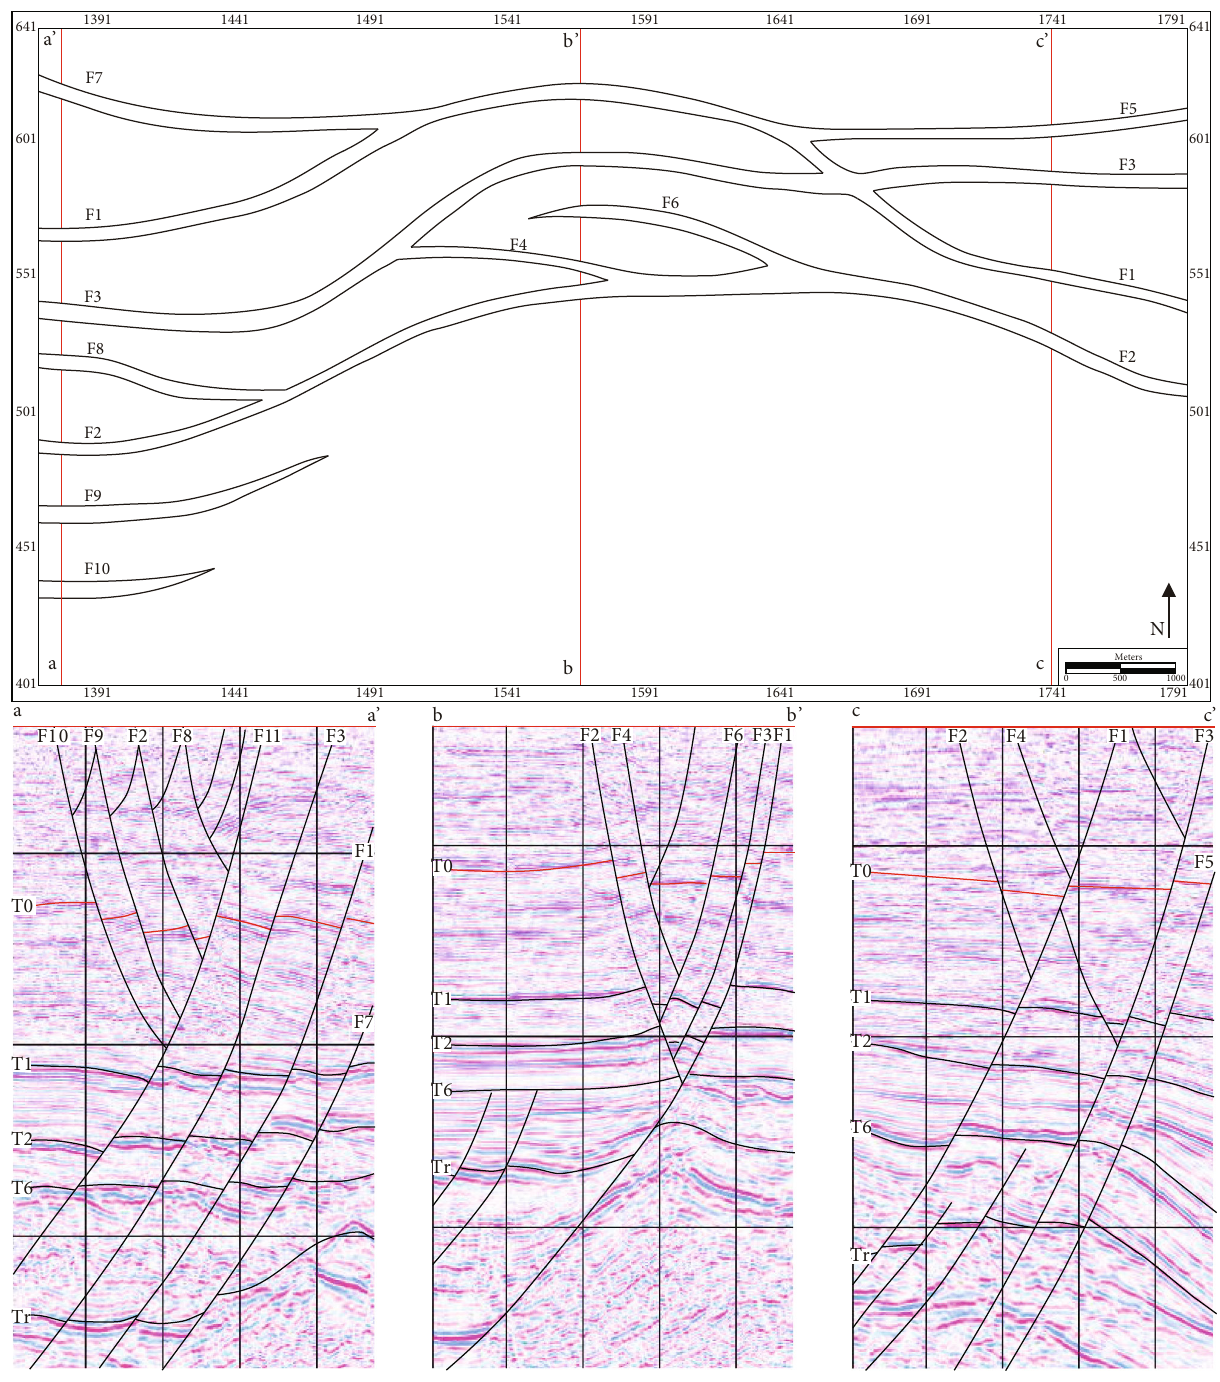
Figure 10: Fault combination styles in plain and section of T0 re fl ection